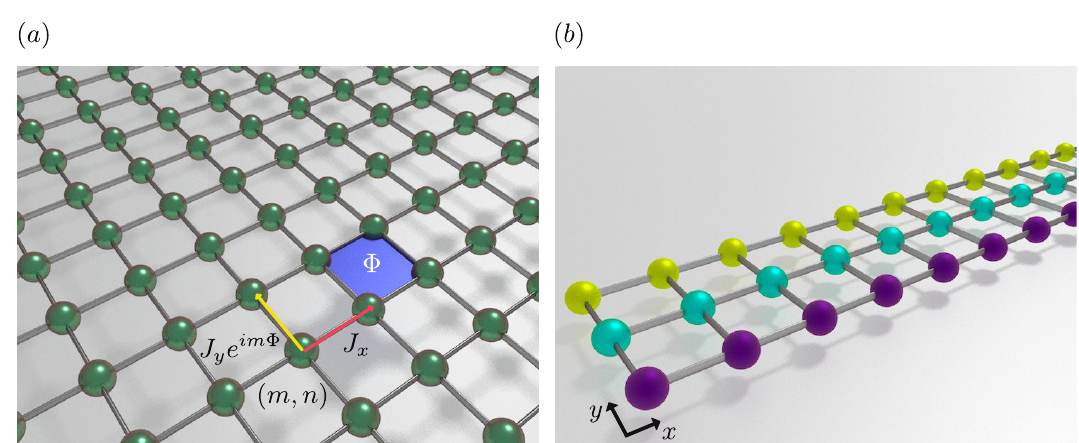
Figure 1: Sketch of the tunnelings of the Hofstadter Hamiltonian, Eq. (1). The site indices in the x , y directions are m , n respectively. The total flux through each plaquette is Φ = 2 π p / q . Panel (a) depicts the usual 2D Hofstadter extended lattice, while panel (b) shows an Hofstadter strip, which contains few states along the y direction (in the example shown, N